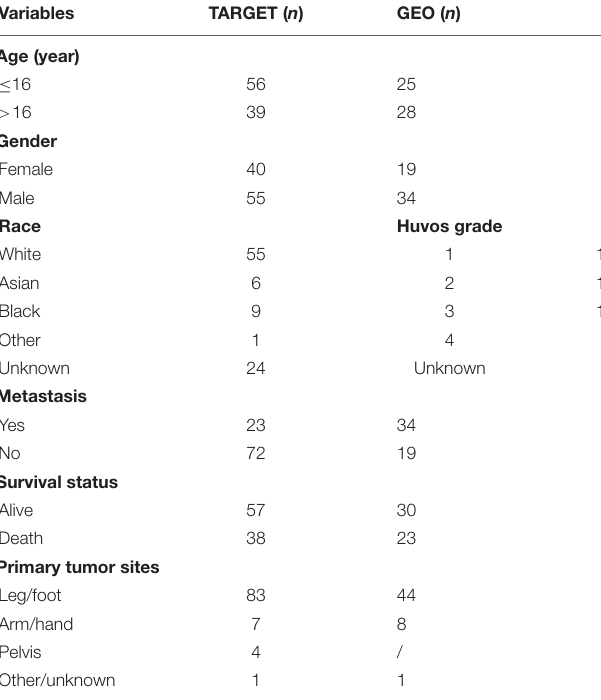
TABLE 2 | Pathways associated with cancer stem cells in the Gene Ontology (GO) and reactome databases. Stem cell function related